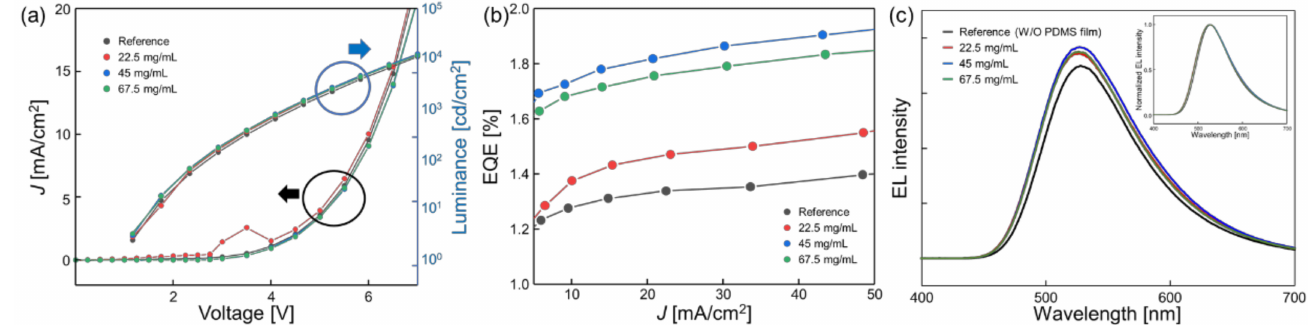
Figure 4. The electroluminescent (EL) characteristics of OLEDs depending on the micro-sphere PDMS film; ( a ) current density–voltage–luminance curve (The black circle is the current density of the left Y-axis, The blue circle is the luminance of the right Y-axis); ( b ) current density–EQE curve (red: 22.5 mg/mL, blue: 45 mg/mL, green: 67.5 mg/mL PS concentration in polymer solution); ( c ) EL spectra of the OLED device with or without each micro-sphere PDMS film with 20 mA/cm 2 (the inset graph shows the normalized EL